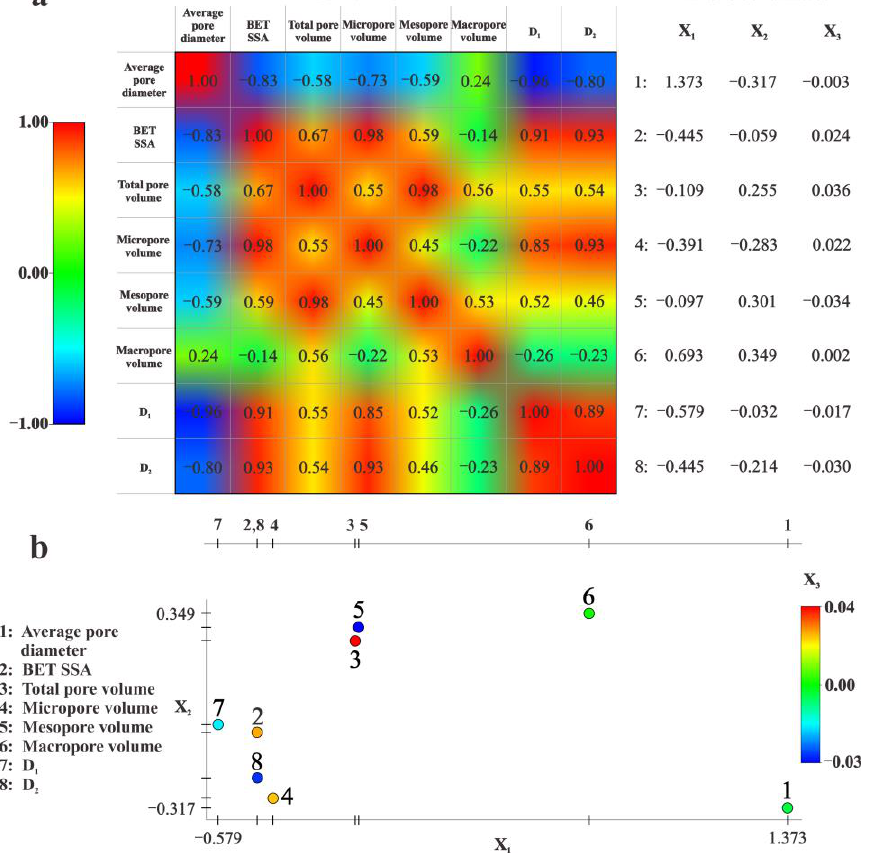
Figure 9. ( a ) Correlation matrix, and ( b ) multidimensional scaling of multivariate pore structure parameters and fractal dimensions of studied lacustrine samples in K 2 qn.